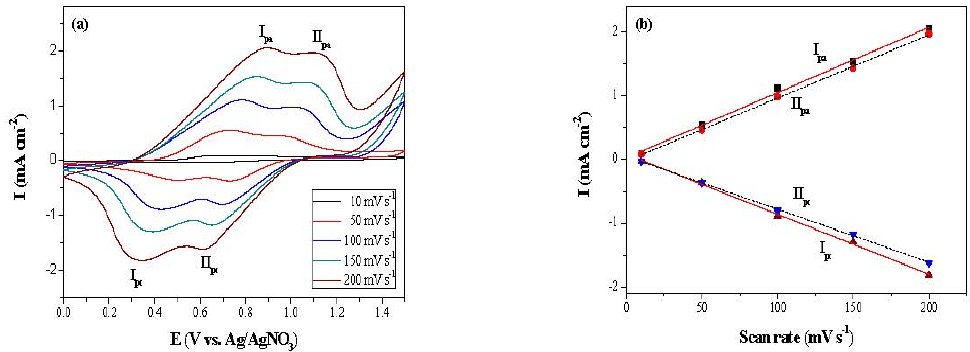
Figure 5. ( a ) CV curves of the P(bCmB- co -bTP) film at scan rates between 10 and 200 mV s − 1 in ACN/DCM (1:1 by volume) containing 0.2 M LiClO 4 . ( b ) Scan rate dependence of anodic and ca- thodic peak current densities for the P(bCmB- co -bTP) film.